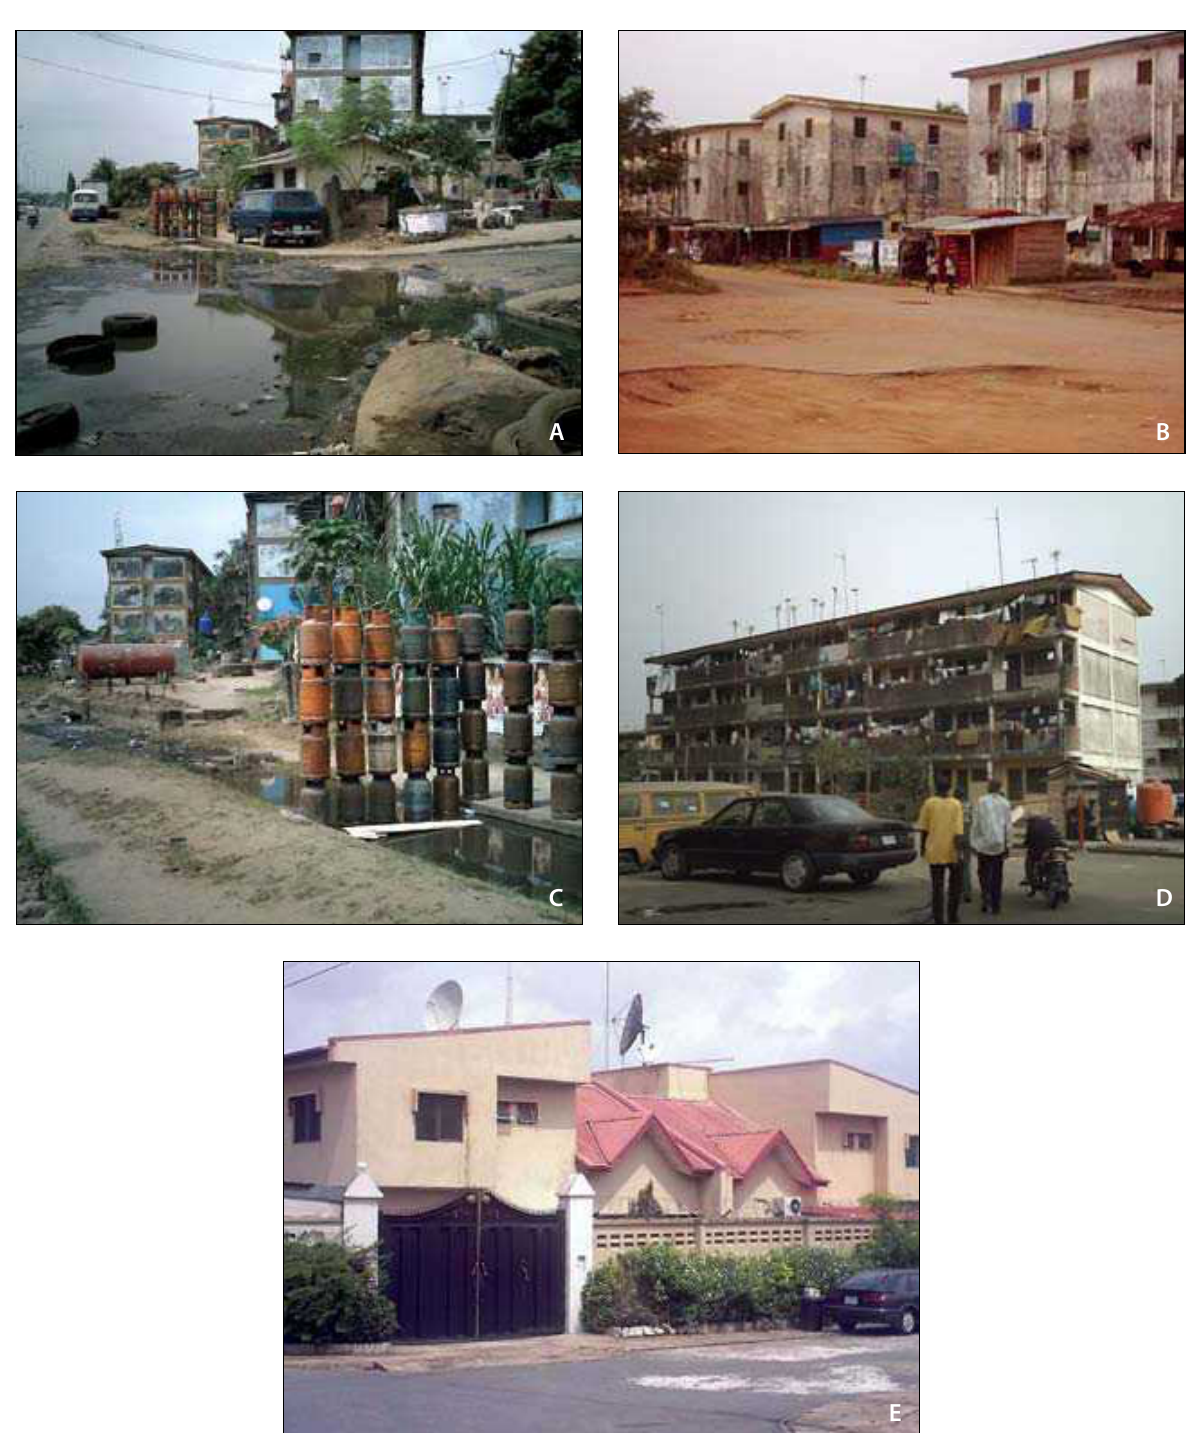
Fig. 2. existing conditions of selected public housing estates in Lagos Metropolis: a – Deplorable road and neighborhood environment a major road flooded and littered with used tyres, b – Defaced buildings and housing environment occupied by makeshift (kiosk) extension for commercial purposes, c – Deplorable environment, and waterlogged drains. Domestic fuel tank and gas cylinders displayed within the neighborhood, D – Misuse of building – balconies used for sun-drying clothes, and indiscriminate vehicular parking in open spaces, e – a typical well-maintained high-class public housing